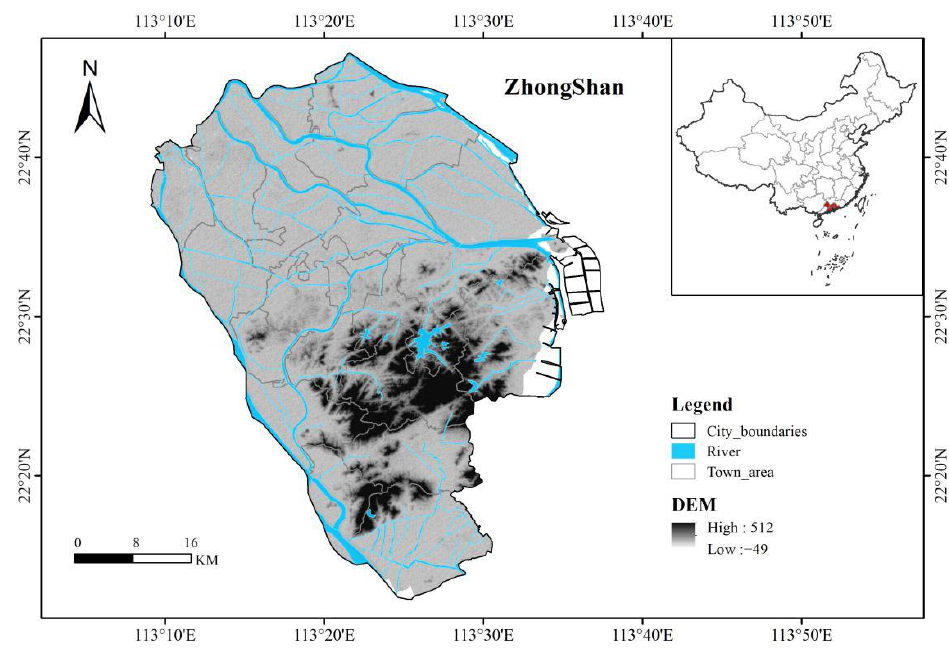
Figure 1. Location of Zhongshan city.